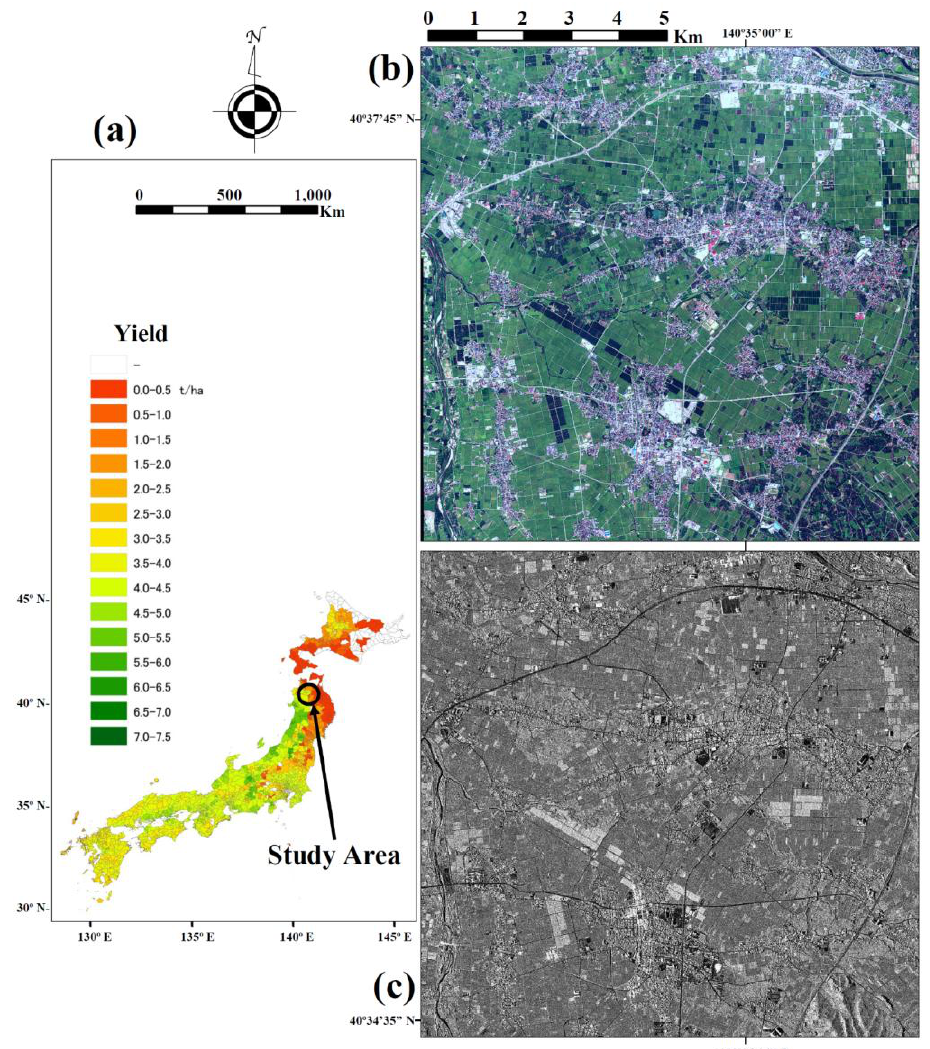
Figure 1. Study area. ( a ) A yield map of rice over Japan in a year (1993) of serious cold damage; ( b ) A natural color image taken by WorldView-2 on 28 August 2011; ( c ) A σ 0 image taken by TSX on 6 September